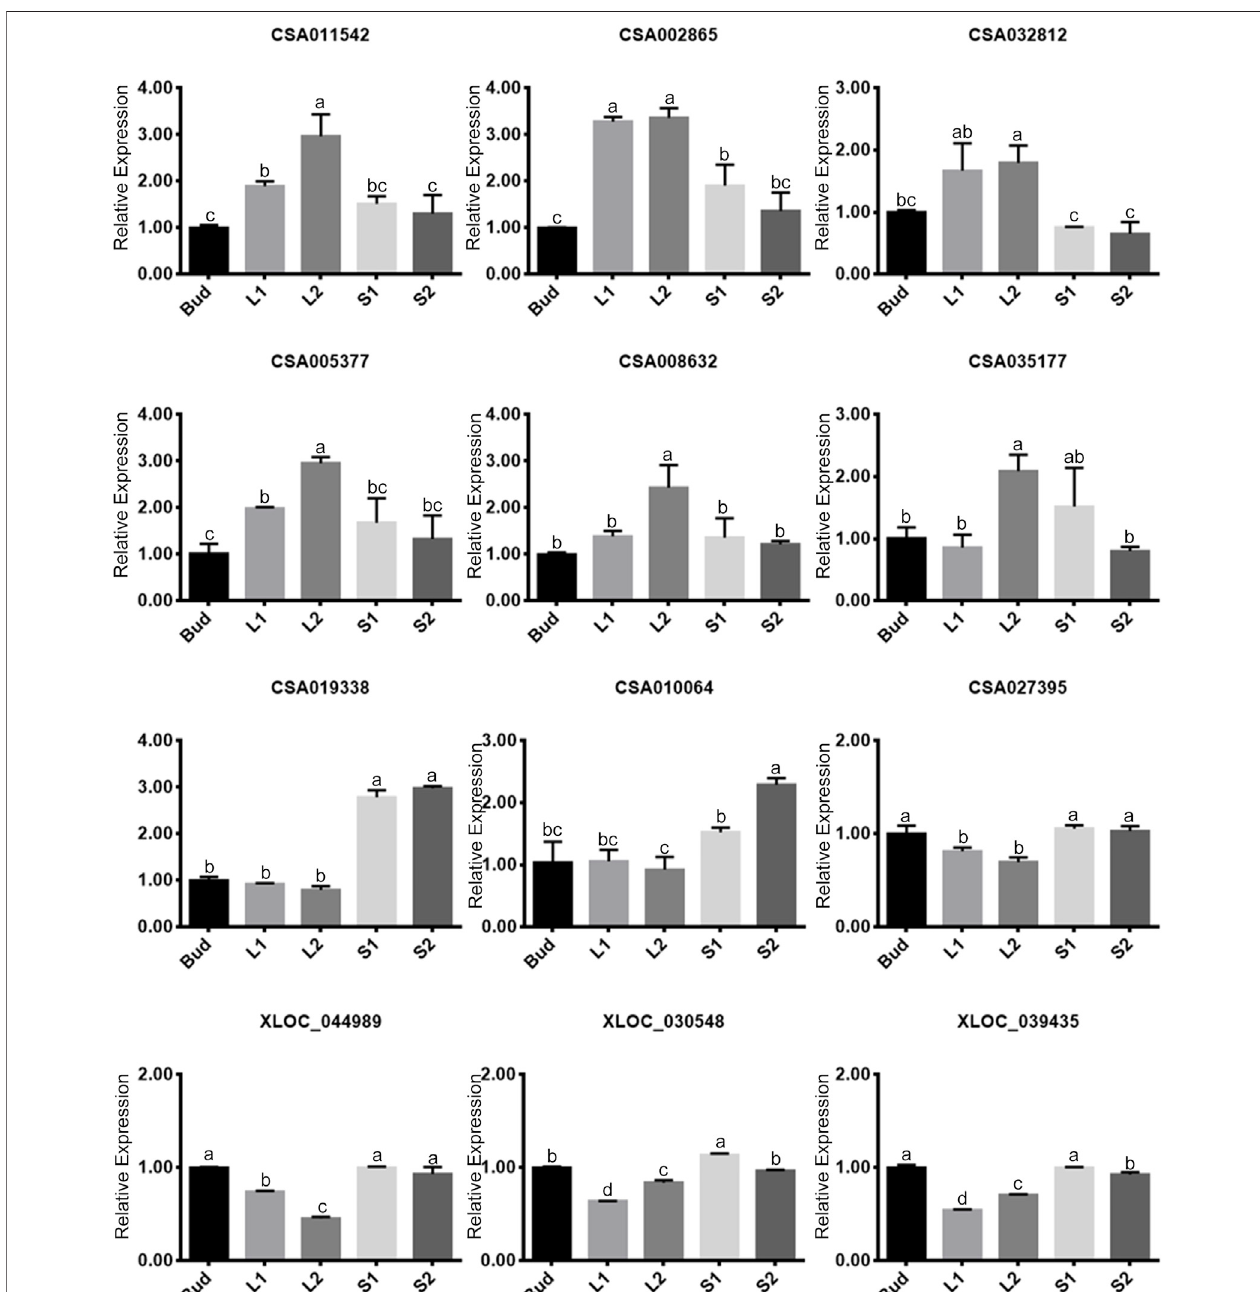
FIGURE 5 | Relative expressions of twelve selected genes by quantitative real-time polymerase chain reaction (qRT-PCR). The former six genes belong topositive modules, and the later six genes belong to negative modules. Data values are the mean ± SD of three independent biological samples. Bars labeled with different lower case letters mean signi fi cant difference ( p -value less than 0.05), while with the same ones mean insigni fi cance ( p -value higher than 0.05).